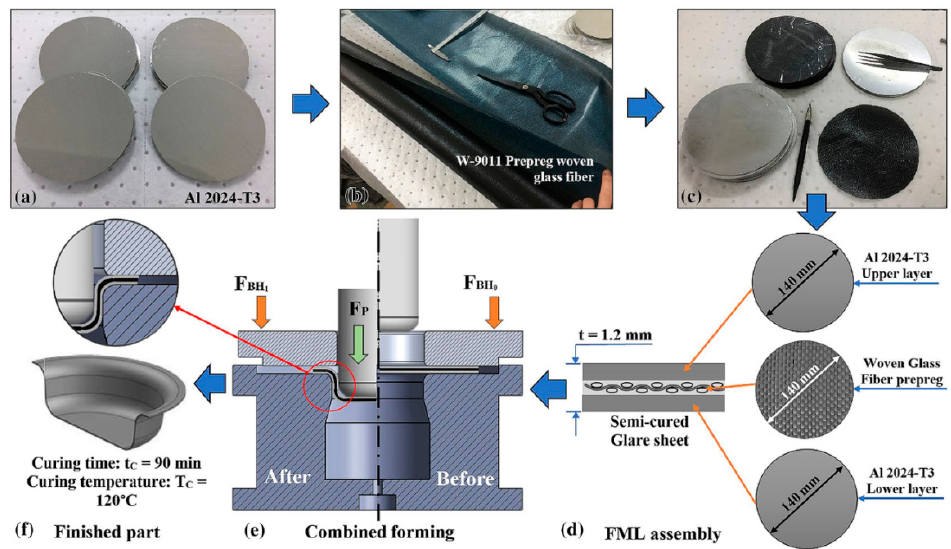
Figure 33. Preparation and forming of GLARE 2/1 using the new optimised process: ( a ) surface treatment of 2024 ‐ T3 sheets, ( b ) optimised 2/1 laminate assembly, ( c ) combined forming, and ( d ) hot pressing (reproduced with permission from [86]; copyright© 2021 Elsevier Ltd.).